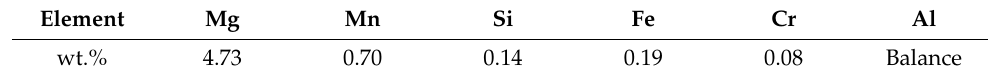
Table 1. Nominal composition of Al5083 alloy [33,34]. Element